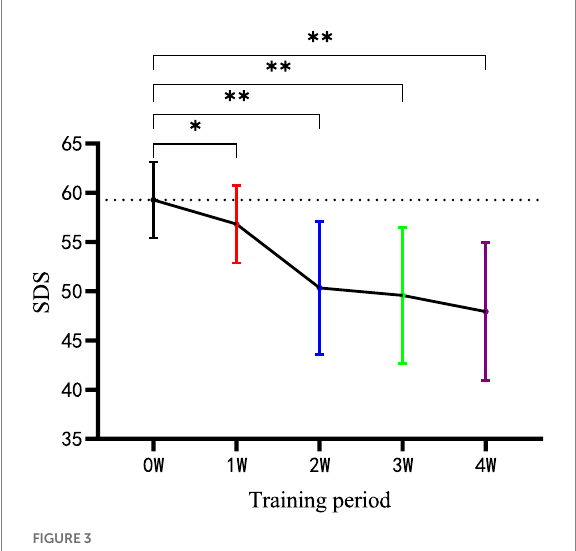
FIGURE 3 Weekly measurement of SDS scores in the HIIT group during the four-week training. SDS, Self-Rating Depression Scale; W, week; * p < 0.05; ** p <